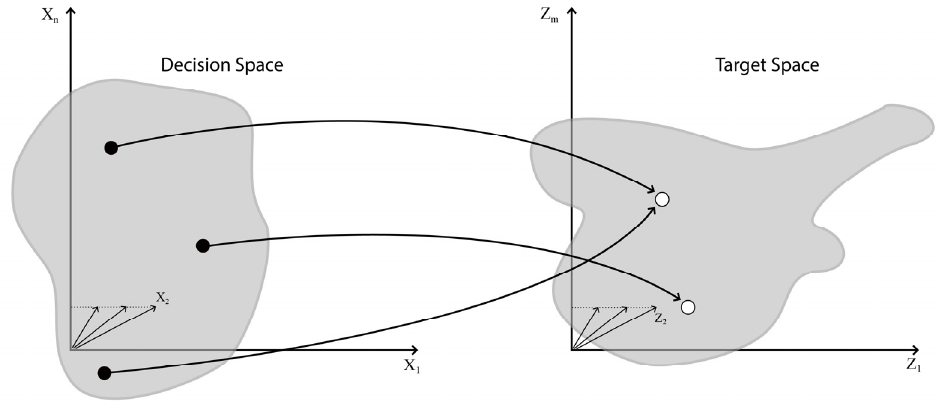
Figure 4. Schematic diagram of data sampling for the decision space and target space involved in multi-objective optimization.